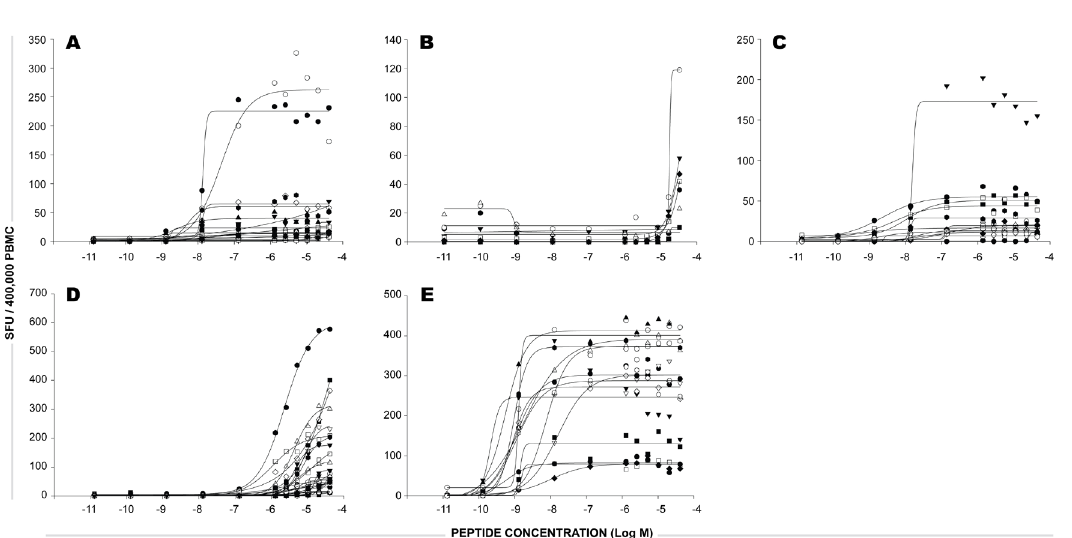
Figure 3. The functional avidity of CEF peptide-reactive CD8 T cells in our HLA-A2- 0201-positive donor cohort. In each panel, data are shown for one of the five HLA-A2 restricted CEF peptides (CEF 3, 4, 5, 6, and 7, in panels A-E, respectively). The different HLA-A2-positive donors are specified by symbols. The PBMC were tested in an IFN- γ ELISPOT assay with decreasing concentrations of the HLA-A2 peptides. Each data point represents SFU from a single well. For each donor and peptide tested, the SFU were plotted on the Y axis against the concentration of peptides used for stimulation in the X